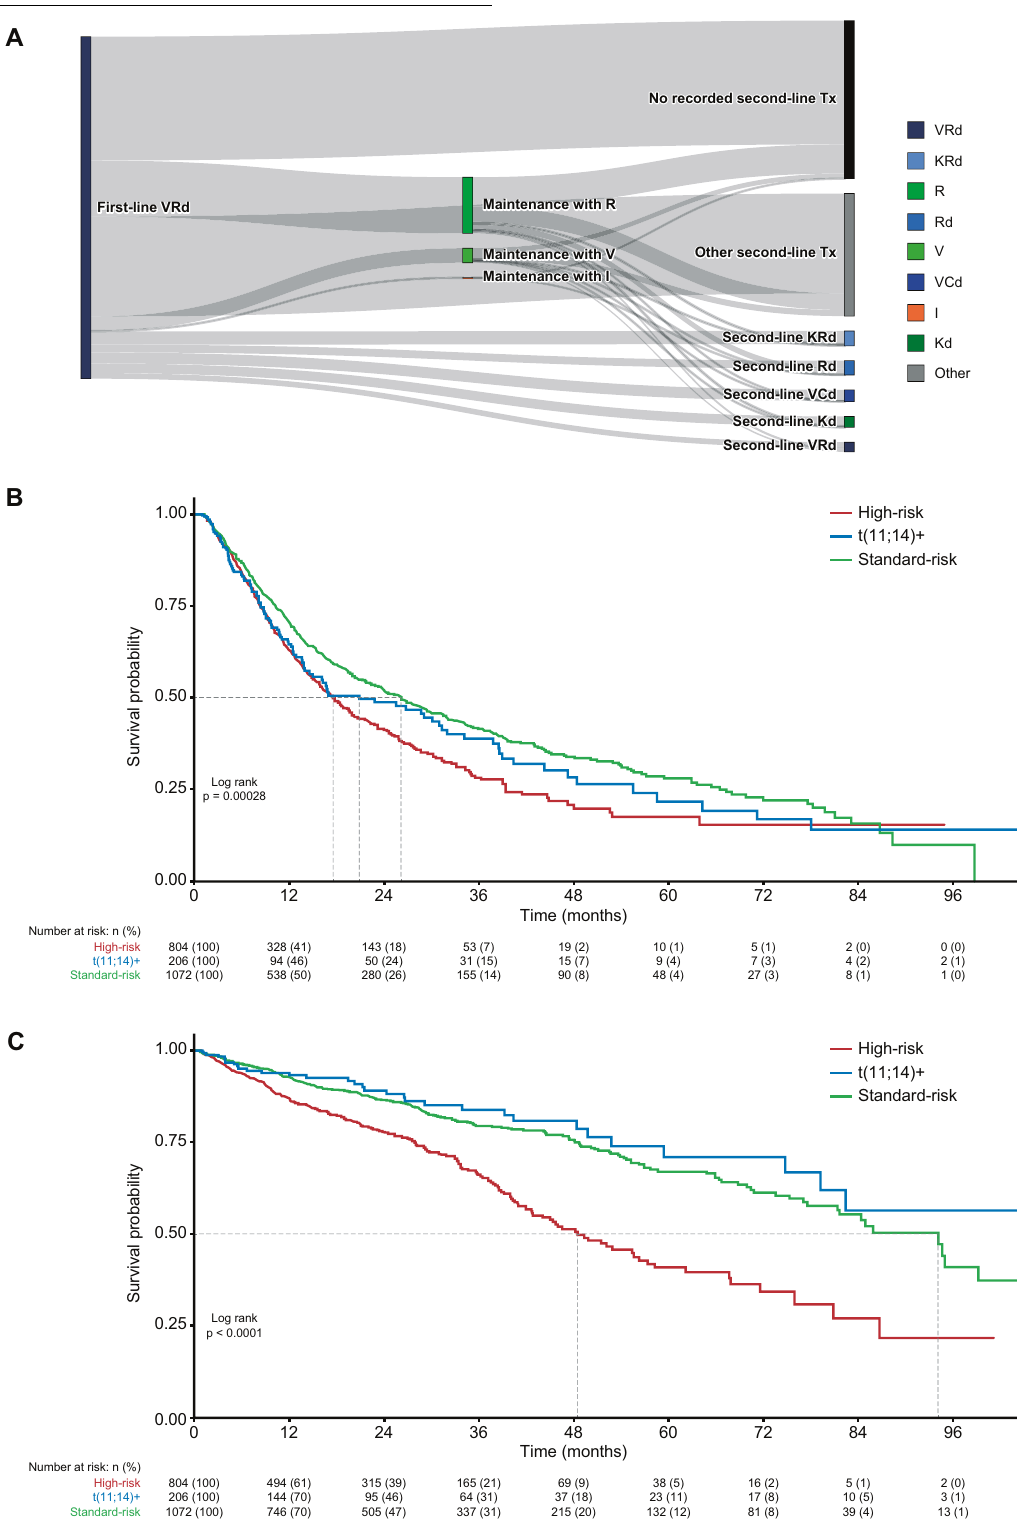
Fig. 5 Sensitivity analysis in patients who received fi rst-line VRd. Sankey plot showing treatment patterns ( A ), and Kaplan – Meier curves for TTNT ( B ) and OS ( C ). OS overall survival, t translocation, TTNT time to next treatment, VRd bortezomib lenalidomide perhaps in part related to disease progression or development of treatments used in 2011 may have been replaced by newer resistance [38, 39]. High-risk patients consistently had poorer regimens) are not speci fi cally addressed in this analysis but have clinical outcomes (TTNT and OS) compared with the t(11;14) + and been reported previously [36, 37]. standard-risk subgroups, irrespective of therapy line, similar to Median TTNT decreased in later treatment lines across all risk fi ndings reported previously [40, 41]. Moreover, patients with subgroups, suggesting that treatment bene fi t decreases over time,